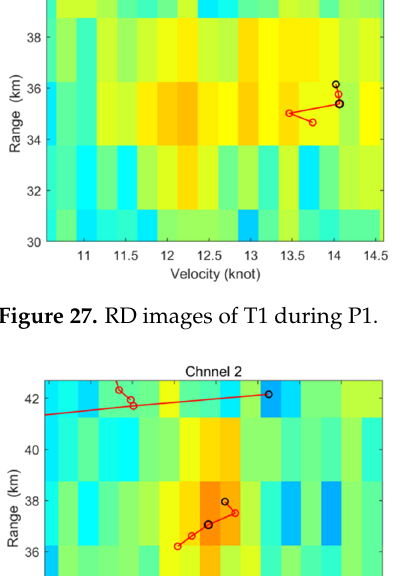
Figure 26. The variation of the ship velocity and heading: ( a ) during P1, ( b ) during P2.